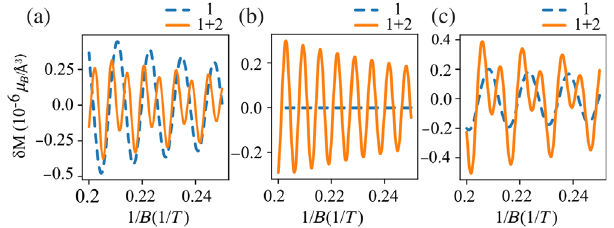
FIG. 4. Magnetization oscillations calculated for Na 3 Bi using Eq. (4) at T ¼ 0 . 37 K; τ ¼ 10 − 12 s; and Fermi energies (a) − 72 meV, (b) − 69 meV, and (c) − 66 meV. The correspond- ing λ 1 are indicated by dashed lines in Fig. 3(b). The sum of the ; 2 two lowest harmonics [ r ¼ 1 , 2 in Eq. (4)], as illustrated by orange solid lines, faithfully represents the oscillations; however, accounting only for the fundamental harmonic ( r ¼ 1 , dashed blue line) is inadequate. The unit of magnetization is chosen as 10 − 6 μ = Å 3 , with μ the Bohr B B